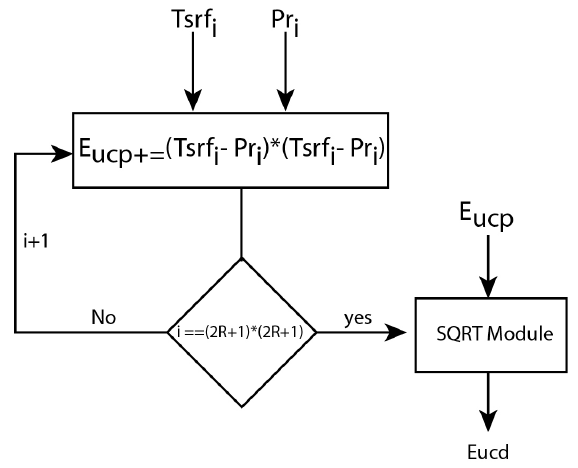
Figure 5. Euclidean distance estimator module